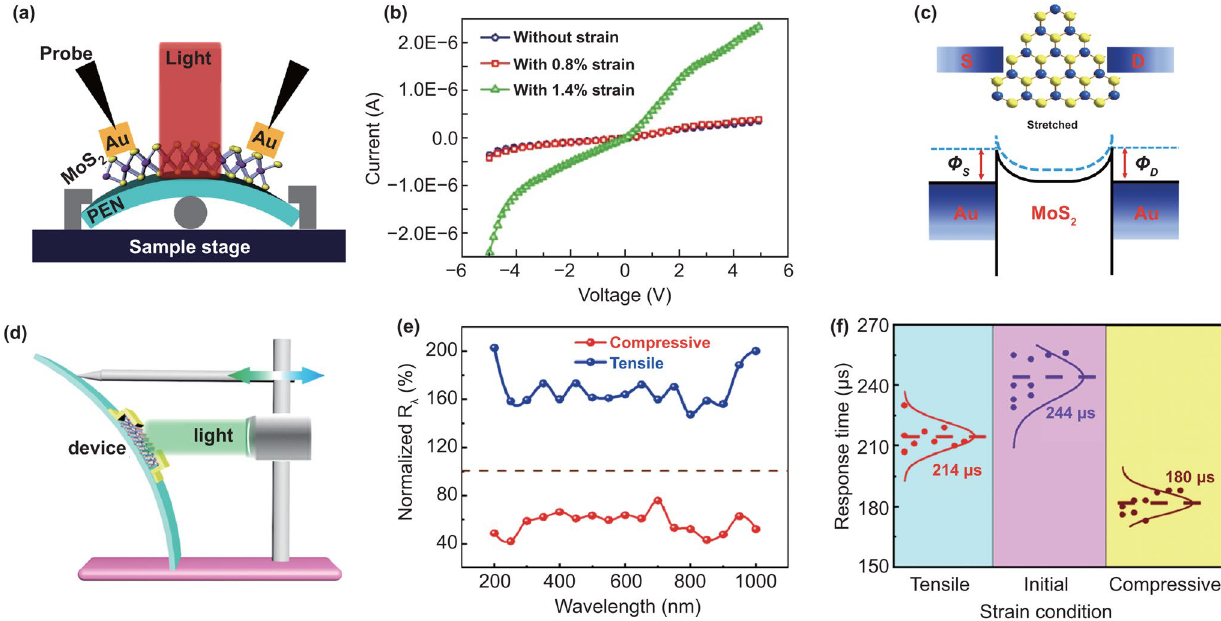
Fig. 17 Tuning the performance of photodetector by strain induced piezoresistive effect. a Schematic illustration for photoelectric performance measurement of monolayer MoS 2 photodetector under strain. b I – V characteristics under light illumination and different strains. c Band diagram of the monolayer